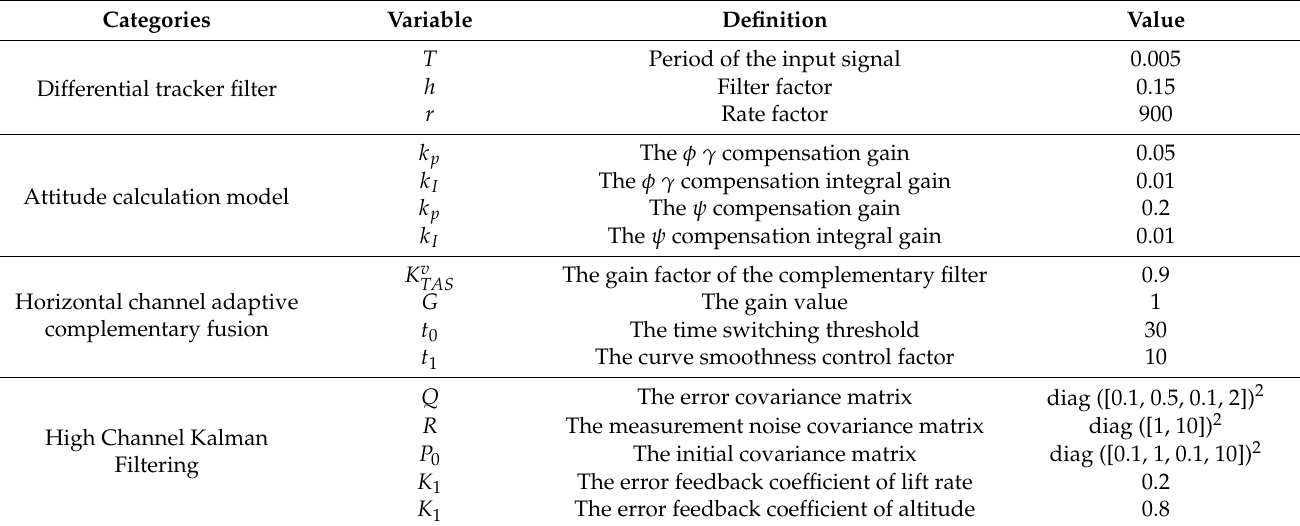
Table 4. The main parameter values of the algorithm we used in the following